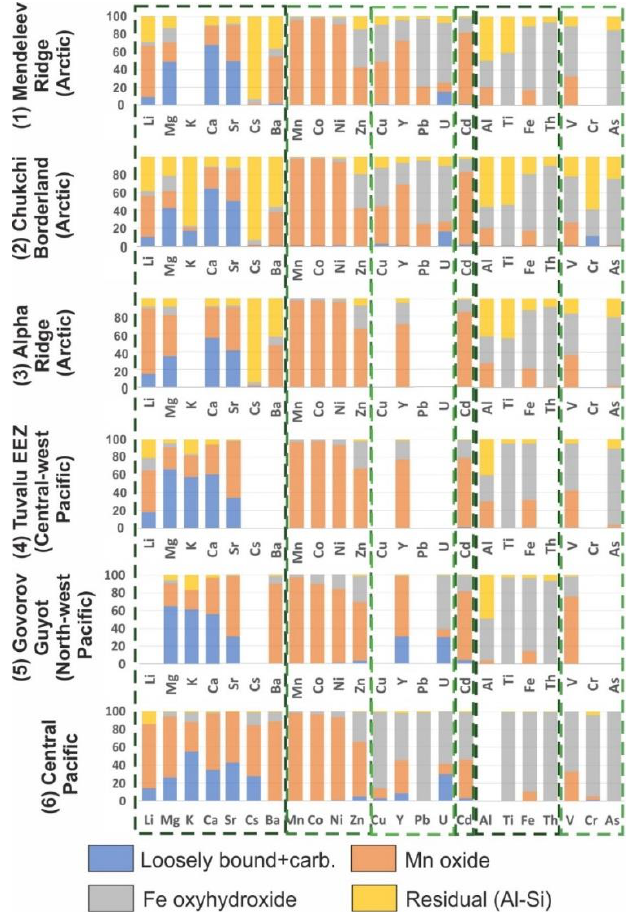
Figure 8. Distribution of element associations among four sequential leaching fractions in hydrogenetic crusts analyzed here, except (6): (1) mean bulk and crust layers from Mendeleev Ridge (Arctic Ocean); (2) mean bulk and crust layers from Chukchi Borderland (Arctic Ocean); (3) bulk crust from Alpha Ridge (Arctic Ocean); (4) bulk crust from Tuvalu area; (5) mean crust layers from Govorov Guyot; (6) crust layer from Pacific Ocean [9]. Elements are divided into six groups (green dash lines) based on data in Table 6. Blank bars are analytical data with poor recovery through the leaching steps with respect to the bulk analyses using a cutoff of 100% ± 20%